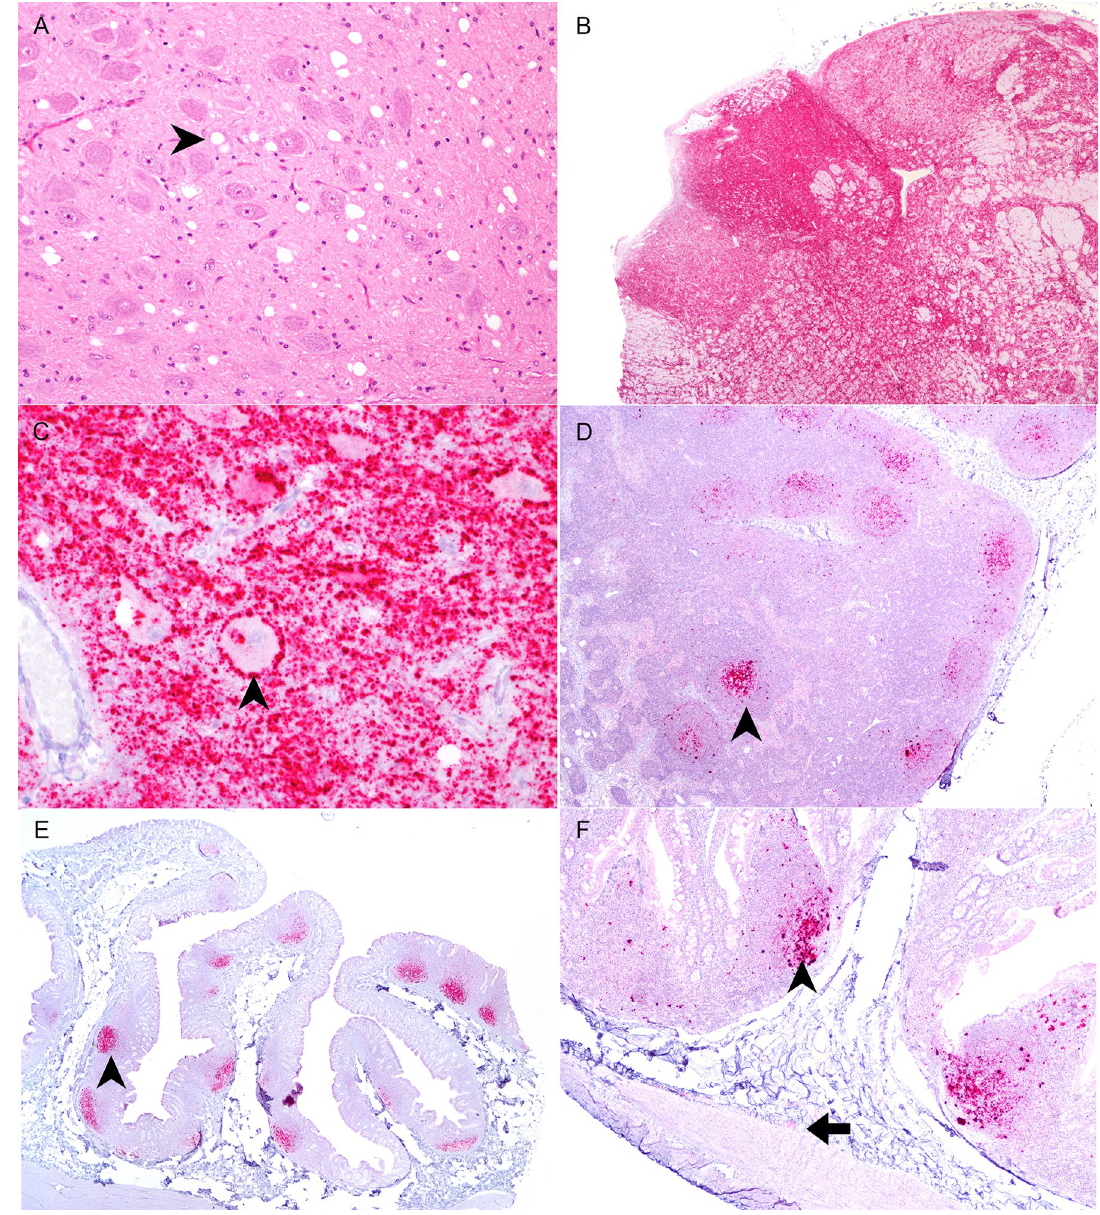
Fig 2. Spongiform change and immunohistochemistry for PrP Sc in tissues from sheep orally inoculated with autoclaved scrapie agent US No. 13–7. (A) Spongiform encephalopathy in sheep #255 that received autoclaved inoculum in the brainstem at the level of the obex (hematoxylin and eosin). An intraneuronal vacuole is indicated by the arrowhead. (B) Immunoreactivity for PrP Sc (red) in the brainstem at the level of the obex in sheep #255. (C) There is abundant coarse granular particulate in the neuropil. Perineuronal and intraneuronal PrP Sc is present (arrowhead). (D) There is positive immunolabeling (red) in a follicle (arrowhead) of the retropharyngeal lymph node of sheep #237. (E) Follicles in the rectoanal mucosa-associated lymphoid tissue are immunopositive for PrP Sc (arrowhead). (F) PrP Sc is present in the small intestinal mucosa-associated lymphoid tissue (arrow) and neurons of the enteric nervous system (arrowhead).